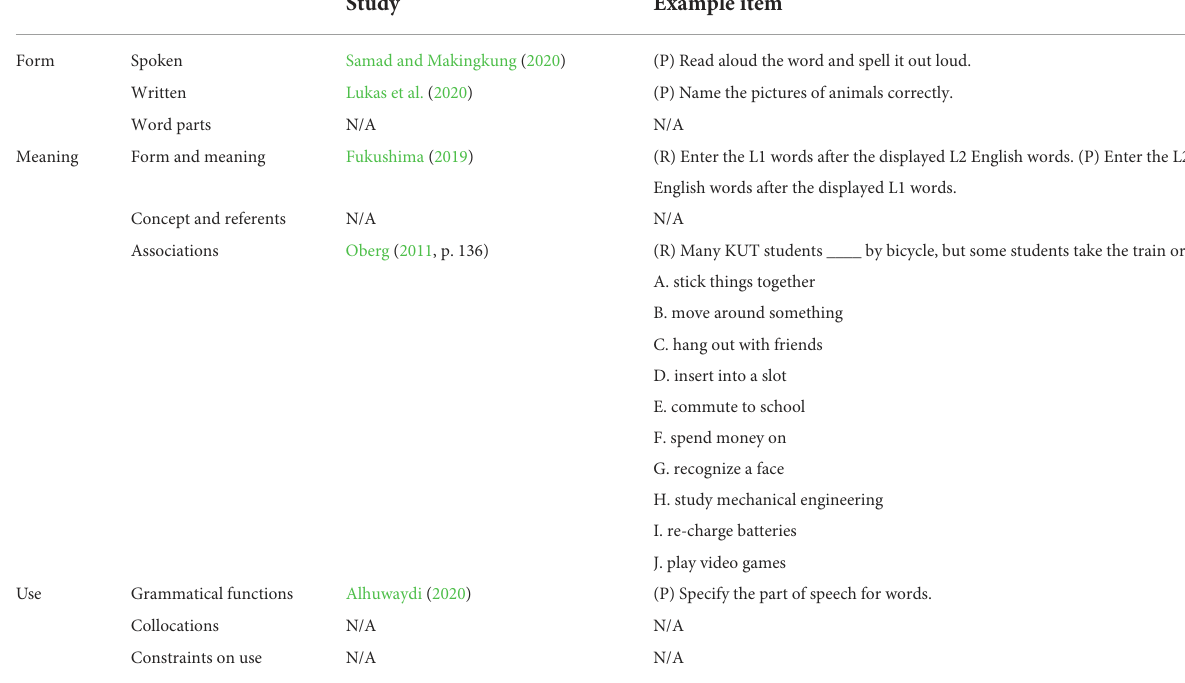
TABLE 3 Researcher-constructed tests of vocabulary